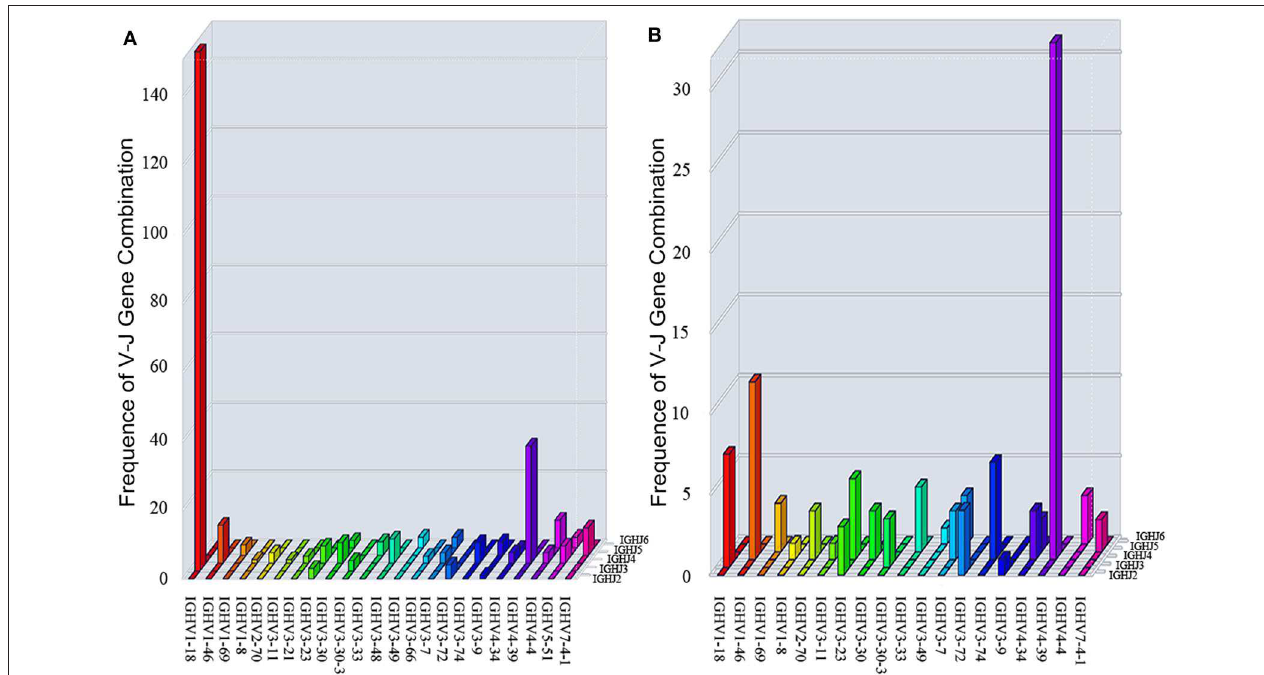
FIGURE 5 | Three-dimensional distribution of V-J gene combination of 12 patients (A) and PA11 (B) . IGH: immunoglobulin heavy chain.